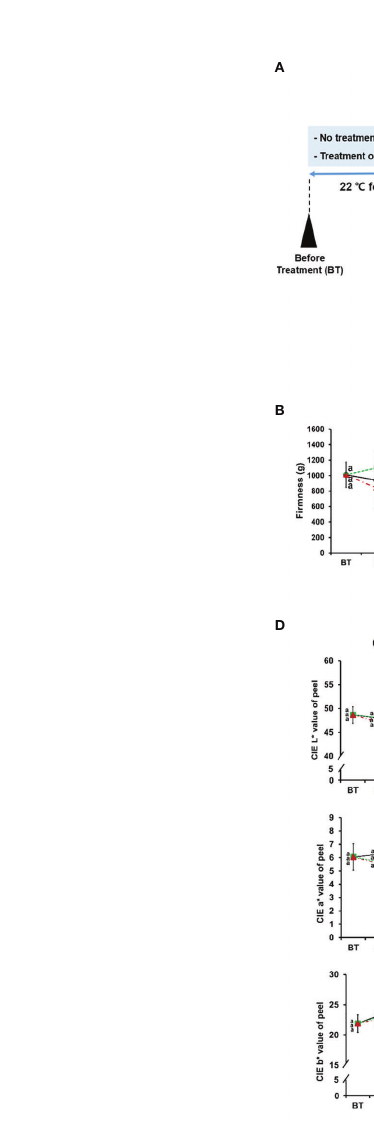
decreased drastically compared to the control sample. Taken together, these results indicated that the experiments with control and ET- and 1-MCP-treated kiwifruit samples were successfully performed throughout ripening.